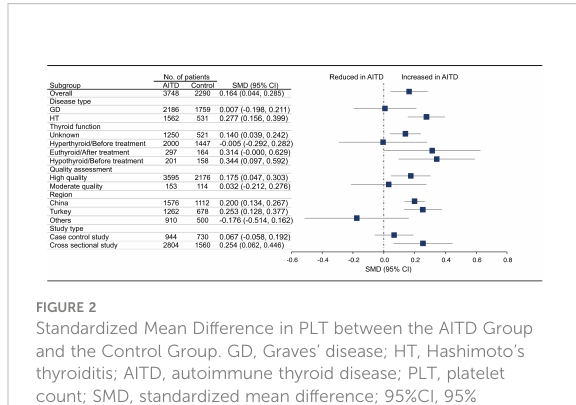
FIGURE 2 Standardized Mean Difference in PLT between the AITD Group and the Control Group. GD, Graves ’ disease; HT, Hashimoto ’ s thyroiditis; AITD, autoimmune thyroid disease; PLT, platelet count; SMD, standardized mean difference; 95%CI, 95% con fi dence interval.